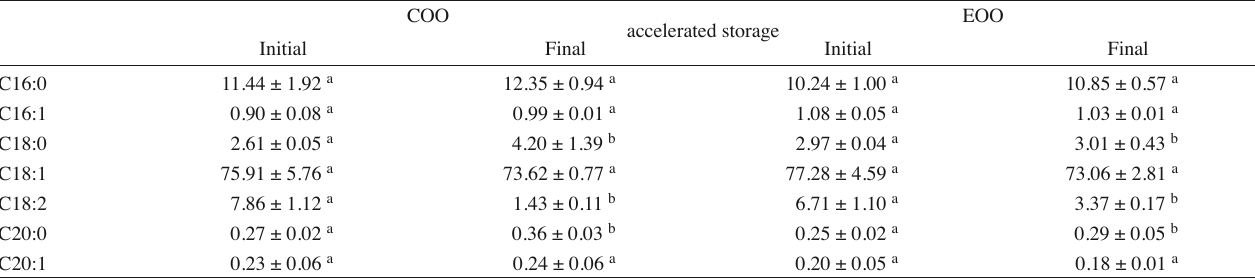
Tab. 4: Fatty acid composition of the COO and EOO before and after accelerated